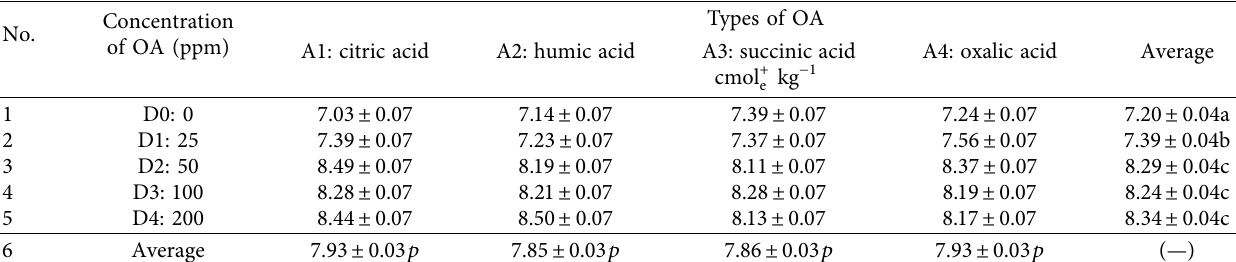
Table 5: Efect of OAs application on phosphate rock to CEC average from 4 observation